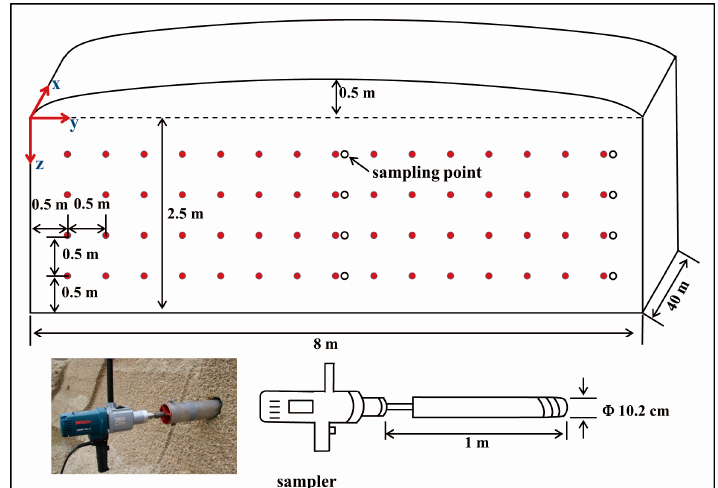
Figure 5. Measurement network showing core sampling location on the bunker silo face (solid dots) and the core sampler dimensions and locations (open circles).